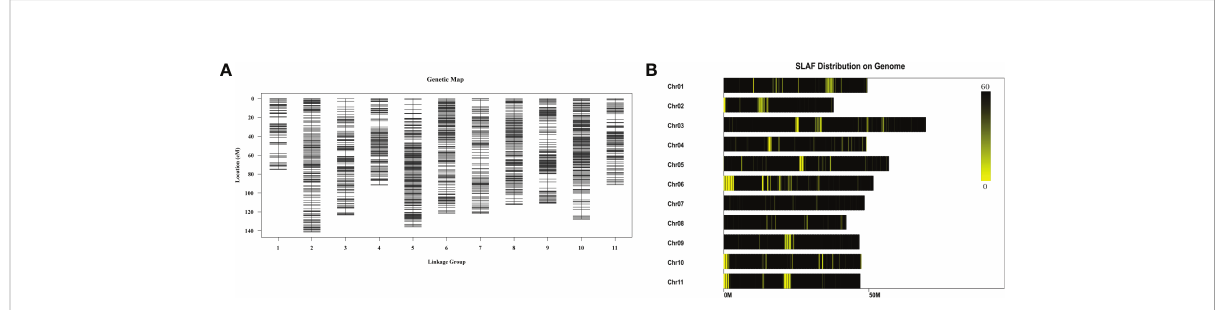
FIGURE 5 Genetic linkage map. (A) . Genetic map. The 9,986 SLAF tags screened out were divided into 11 linkage groups by mapping with the reference genome, and the tags whose MLOD values between the two tags were both > 3 were fi ltered out, and a total of 4,257 tags were markers.